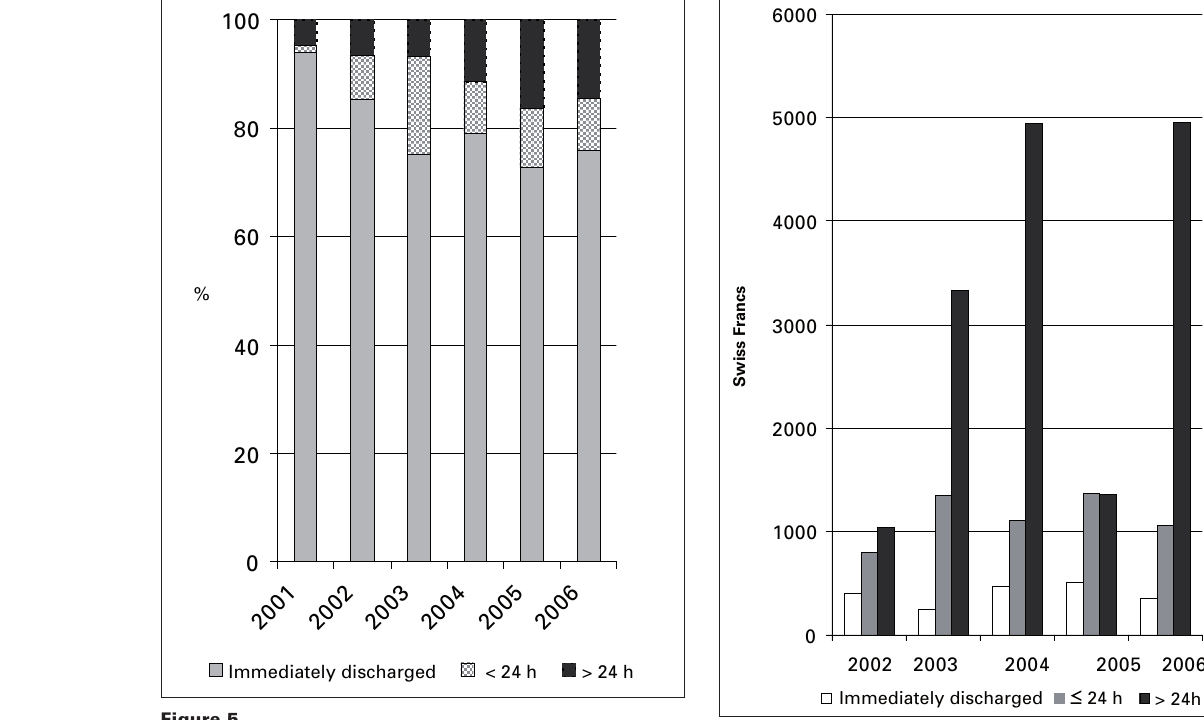
Figure 5 Treated patients [%] according to duration of hospitalisation.